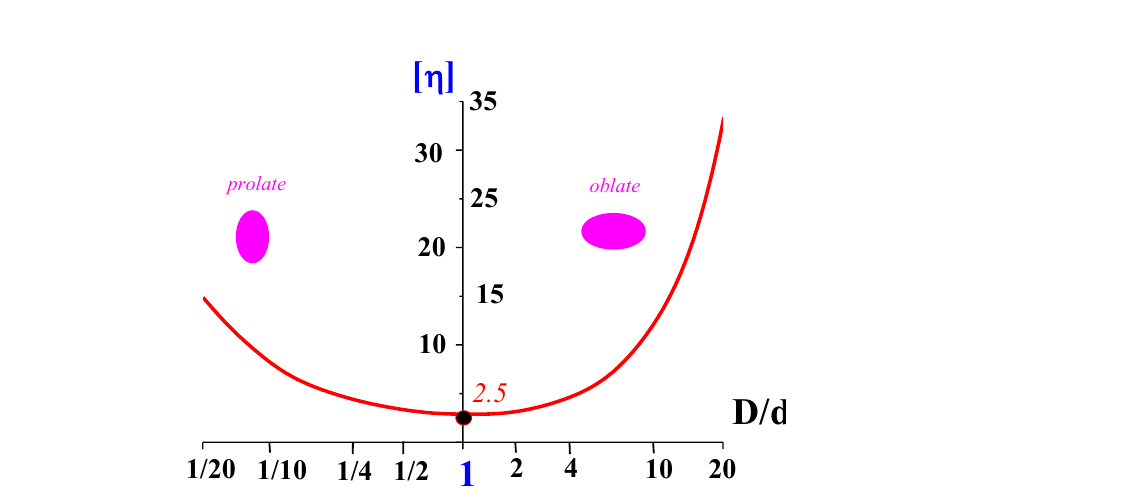
Figure 14. Influence of the anisotropy of solid particles on intrinsic viscosity (according to G.B. Jef- frey (1922) and W. Kuhn and H. Kuhn, (1945)).